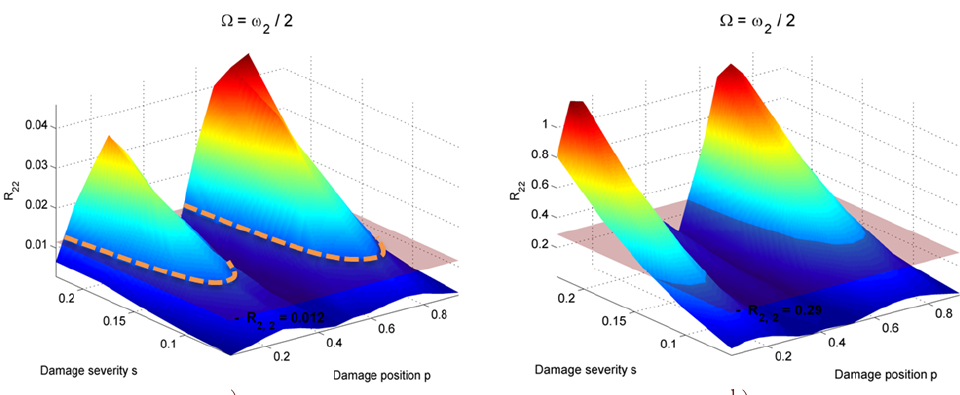
Figure 2: Simple supported beam: Harmonic damage surfaces R 22 order 2 super-harmonic component for = /2; a) symmetric loading condition; b) asymmetric loading